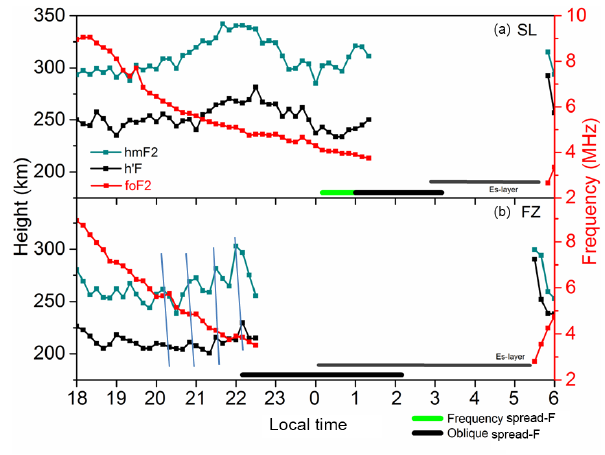
Figure 2. F-layer parameters h (cid:48) F (km), hm F2 (km), and fo F2 (MHz) on 25–26 July 2011 obtained from the digisondes at SL (a) and FZ (b) .